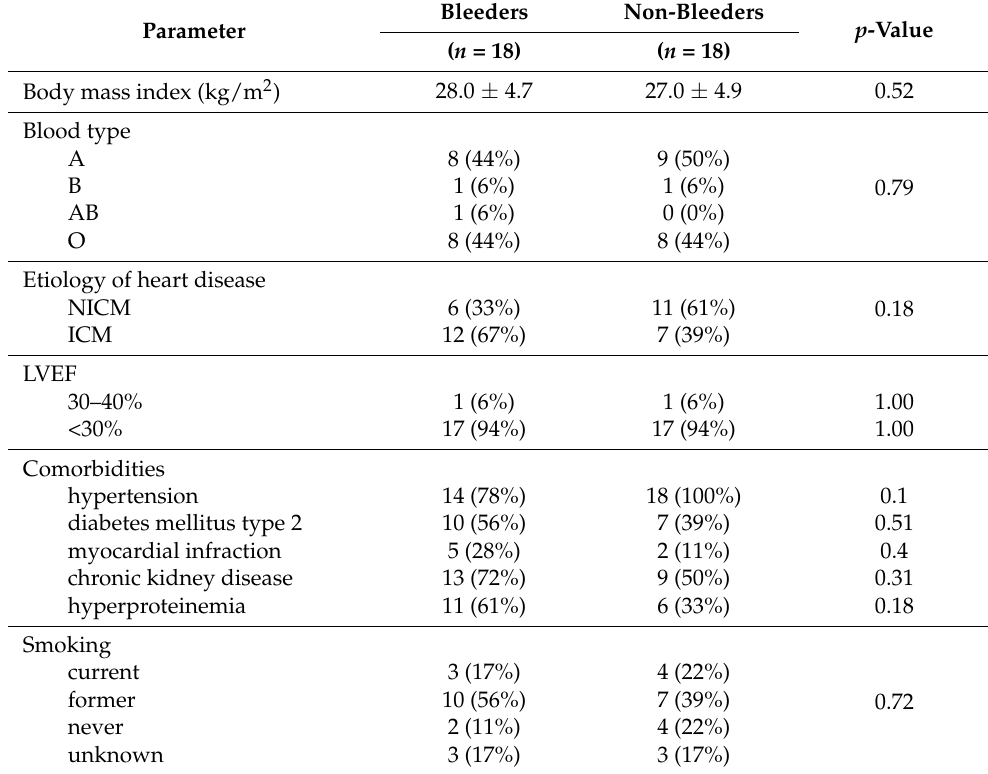
Table 1. Demographic and clinical characteristics of bleeders and the non-bleeders prior to LVAD implantation and LVAD-related